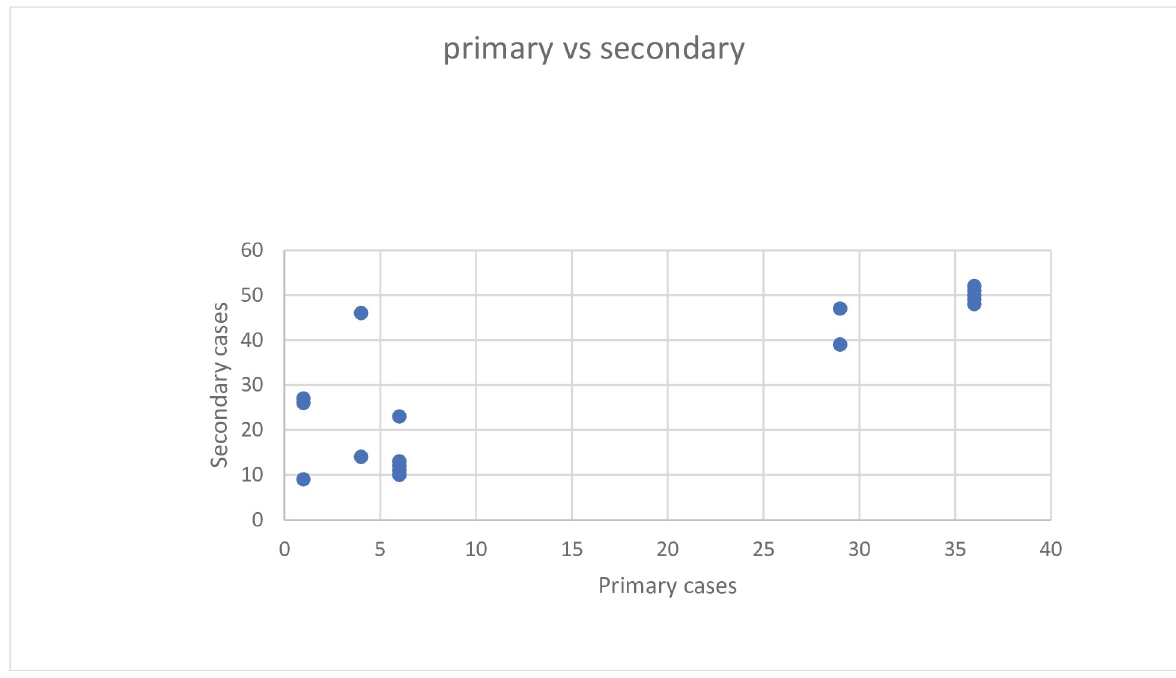
Fig 4. Primary versus secondary cases of